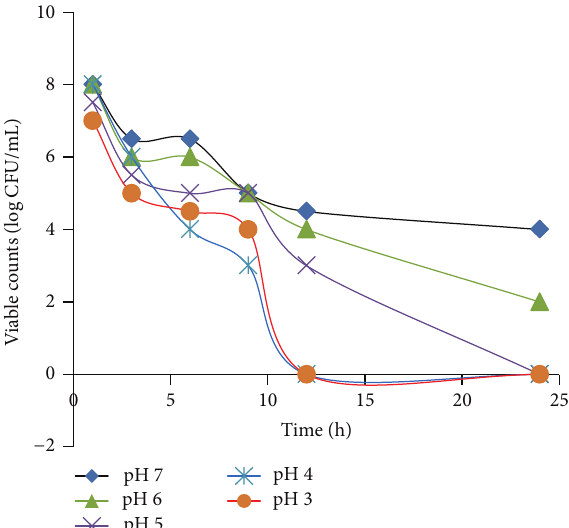
Figure 6: Effect of medium pH on the anti- H. pylori activities of silver nanoparticles against NCTC 11637.